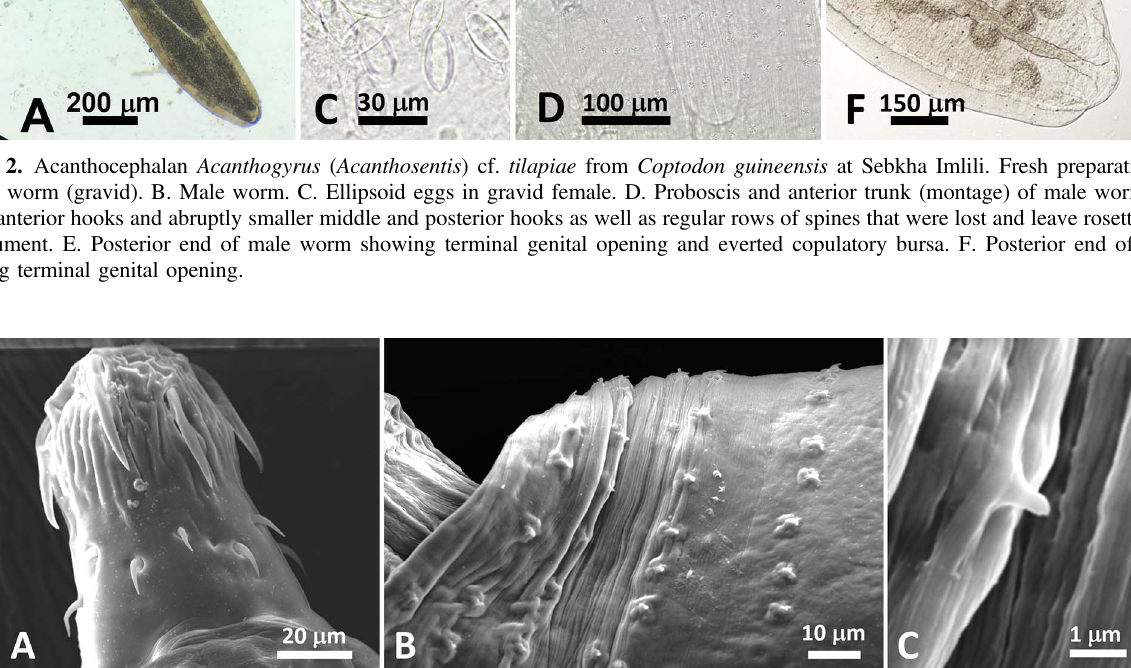
Figure 3. Acanthocephalan Acanthogyrus ( Acanthosentis ) cf. tilapiae from Coptodon guineensis at Sebkha Imlili. SEM. A. Male proboscis showing large anterior hooks markedly separated from small posterior hooks. B. Anterior trunk of female showing rows of spines. C. Female body